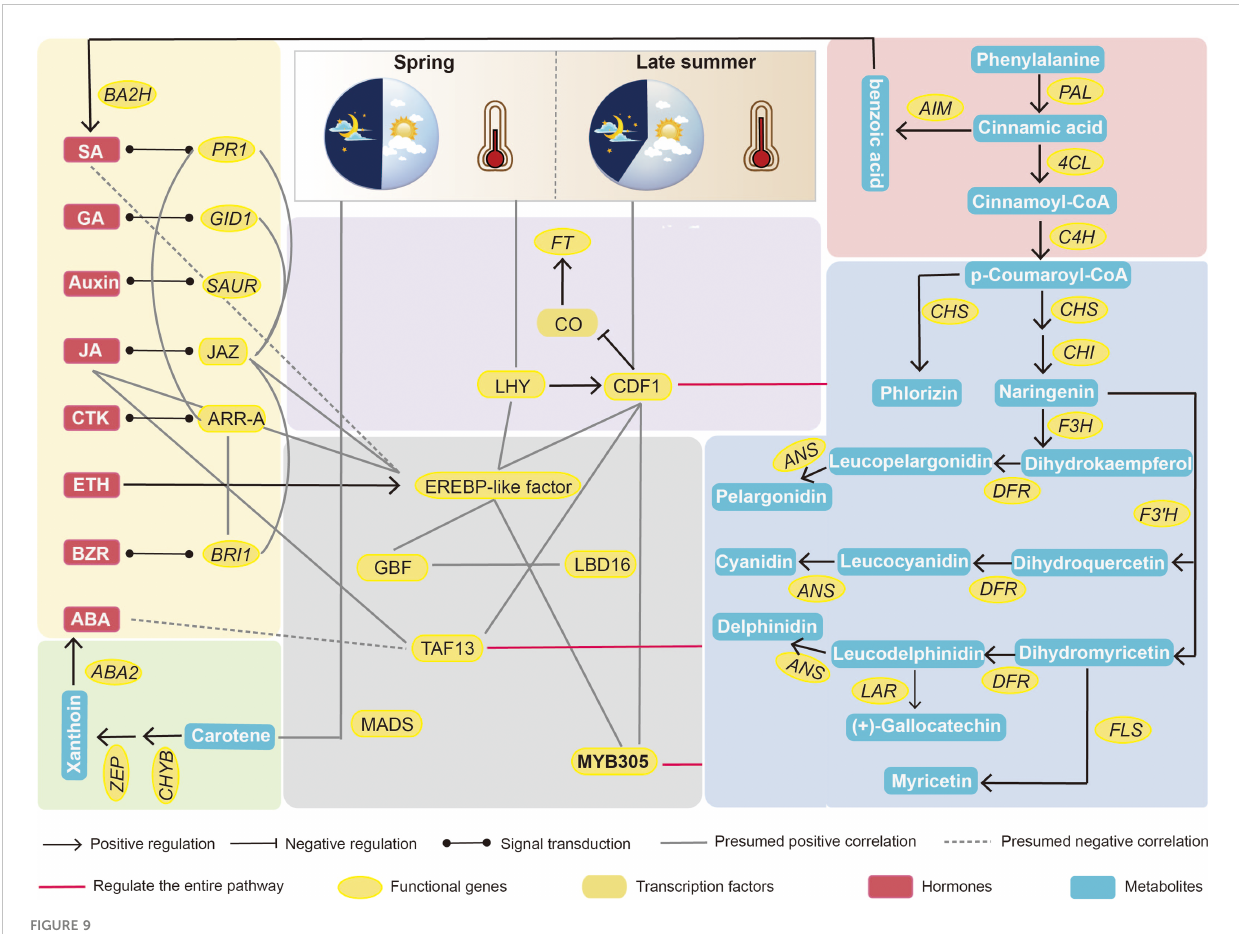
FIGURE 9 Integrated transcriptome, metabolome and phytohormones analysis provides new insights into the molecular regulatory network of the difference between fi rst and secondary fl ower development in chestnut. MYB305 may be a key transcription factor affecting sex differentiation in